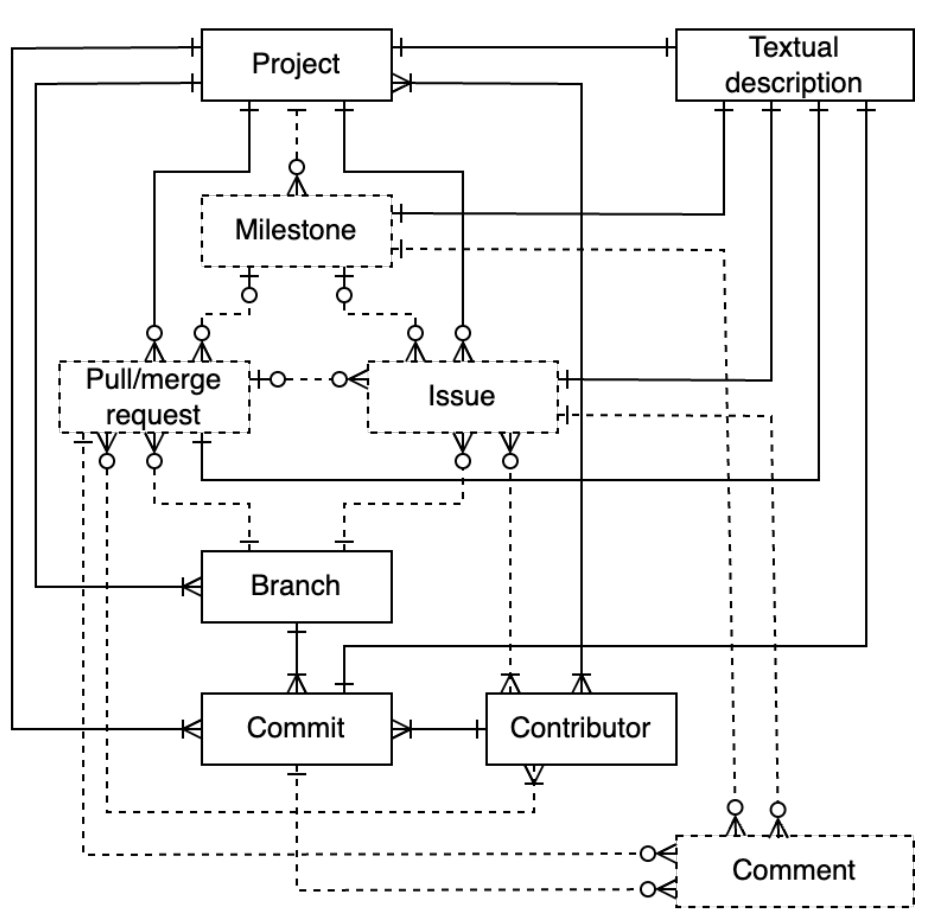
Figure 2. ER diagram of the L B representation of the software development